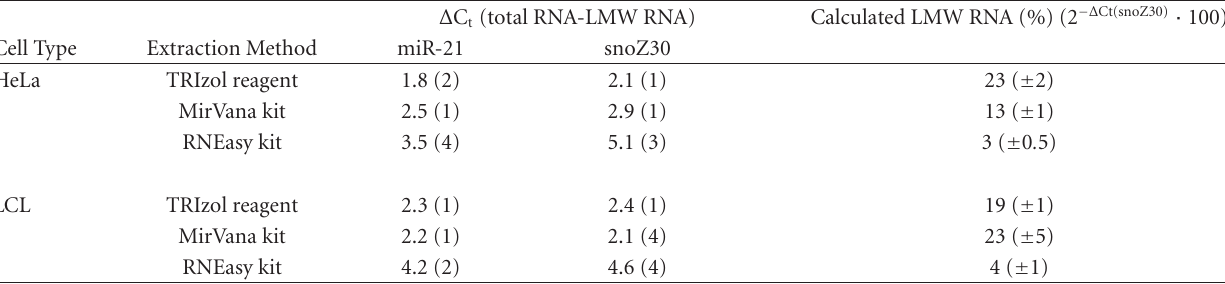
Table 2: Real-time PCR data obtained for HeLa and LCL were compared calculating the Δ Ct di ff erences between Ct (10ng of total RNA) and Ct (10ng of LMW RNA) values for miR-21 and snoZ30. Standard deviations of at least three independent assays are reported in parentheses. LMW RNA concentrations (%) calculated using the formula 2 − Δ Ct · 100 are also reported where Δ Ct are referred to snoZ30 values. Standard deviations of at least three independent assays are reported in